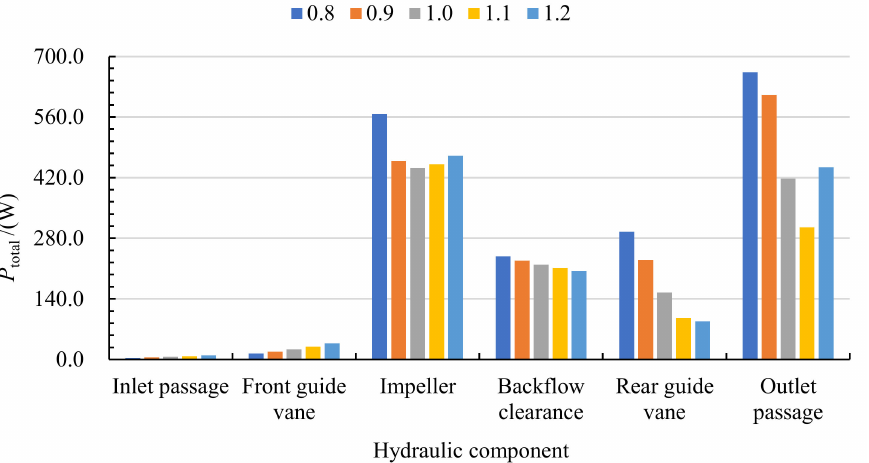
Figure 7. Comparison of total dissipation for each hydraulic component under different Q / Q des ( R b = 2 mm).